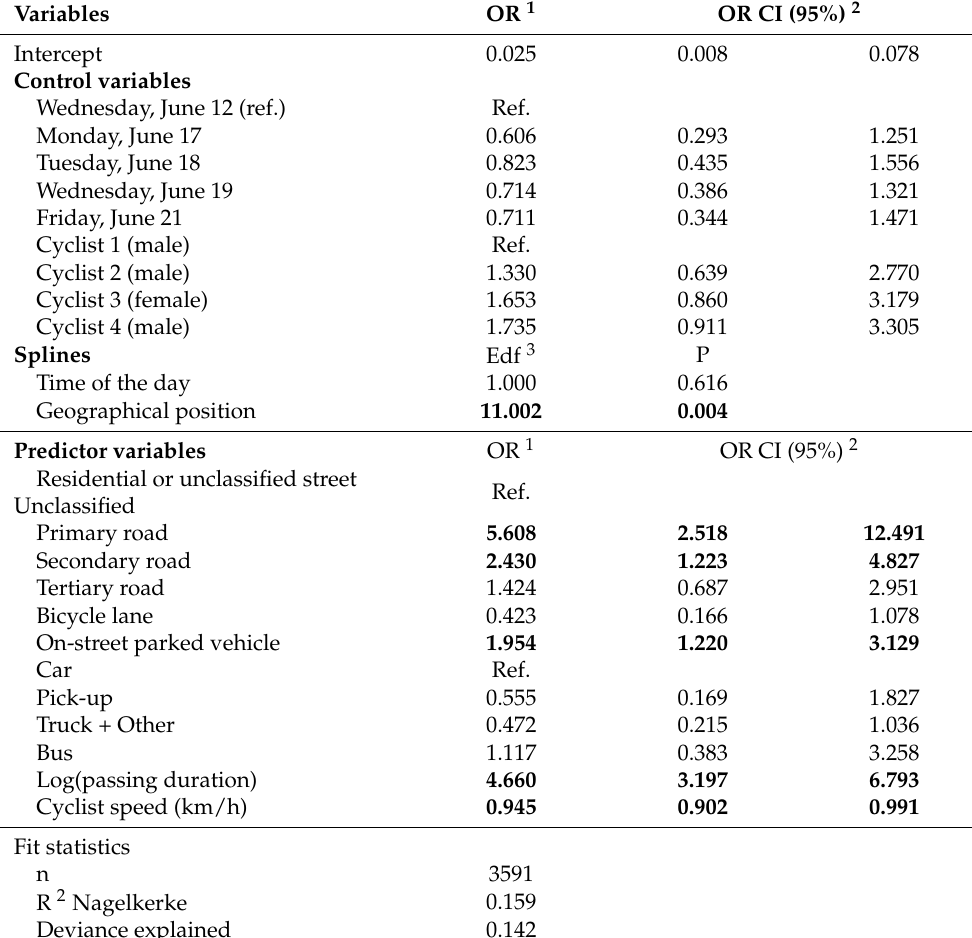
Table 4. Results of the generalized additive logit